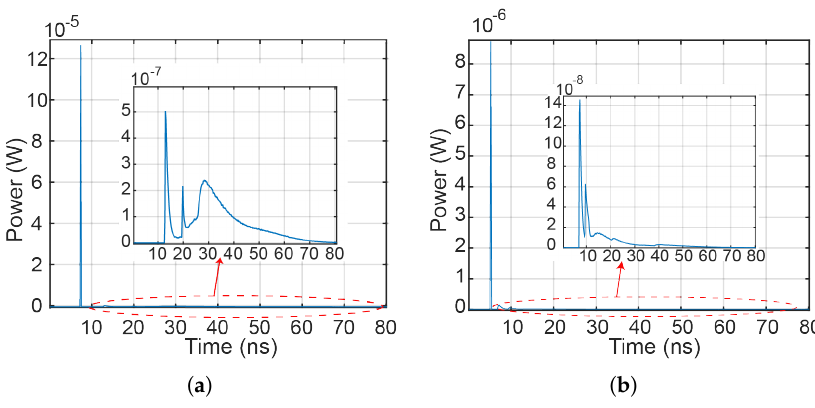
Figure 6. Impulse response for VLC with RN for: ( a ) source to RN; and ( b ) RN to the